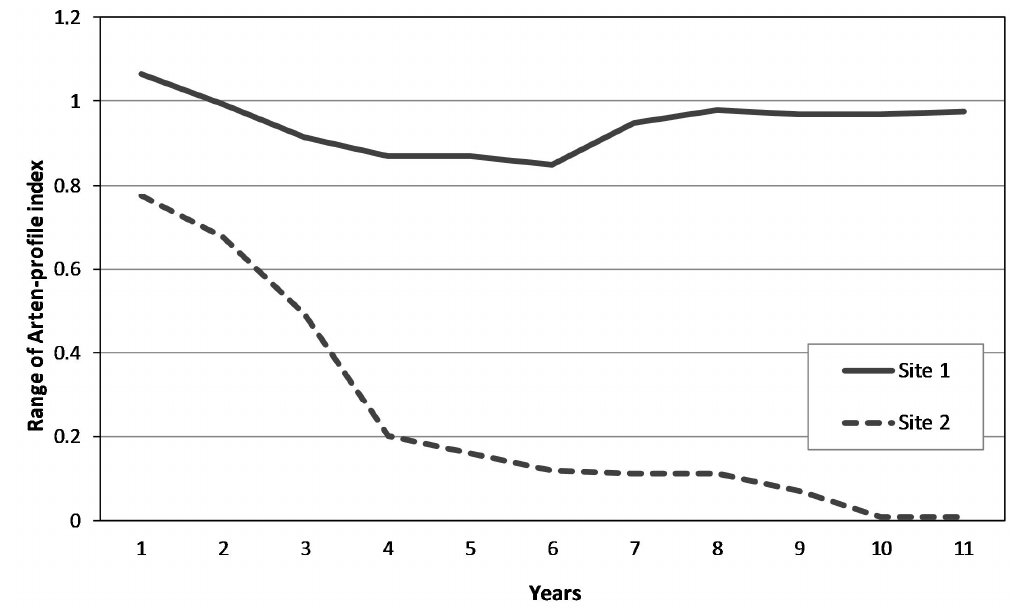
Figure 8. Prediction of the standardized Arten ‐ profile index values for both study sites.